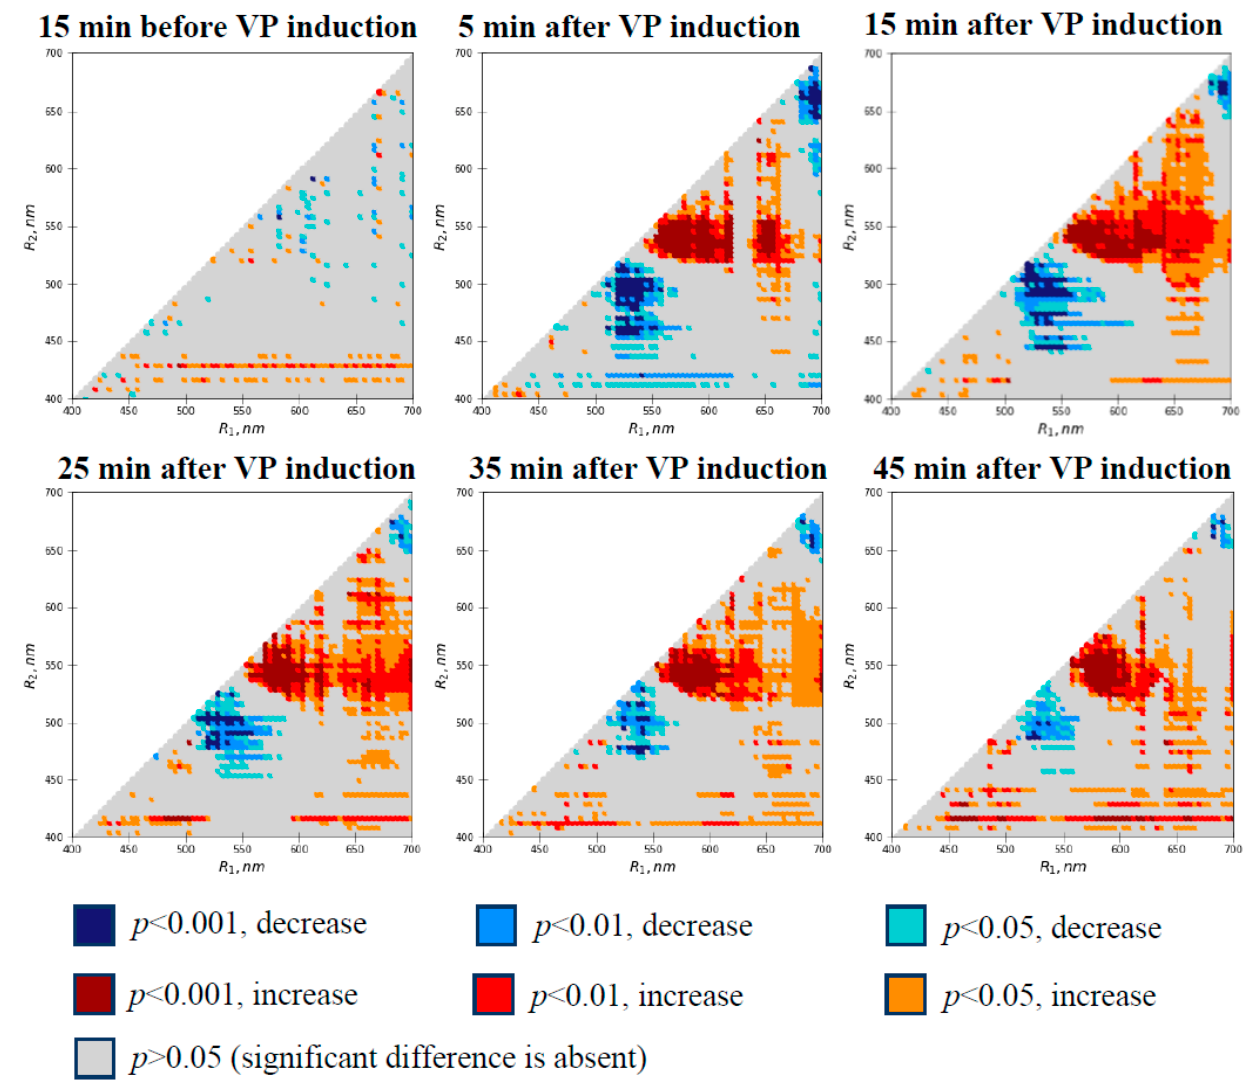
Figure 3. Heat maps of significance and directions of changes in ∆ RIs in the second pea leaf at different time intervals before and after induction of variation potential ( n = 13). RIs were calculated based on Equation (1). Burning of the first leaf was used for VP induction. Each ∆ RI was calculated as RI TP –RI C . RI C is the control RI at 5 min before the VP induction. RI TP is the difference in the reflectance index at a specific time point before or after VP induction. The Mann–Whitney U test was used for p -value calculations. The ∆ RIs were compared to zero values (absence of changes). Using ∆ RIs minimized the influence of individual plant differences on the local burning-induced changes in RIs.